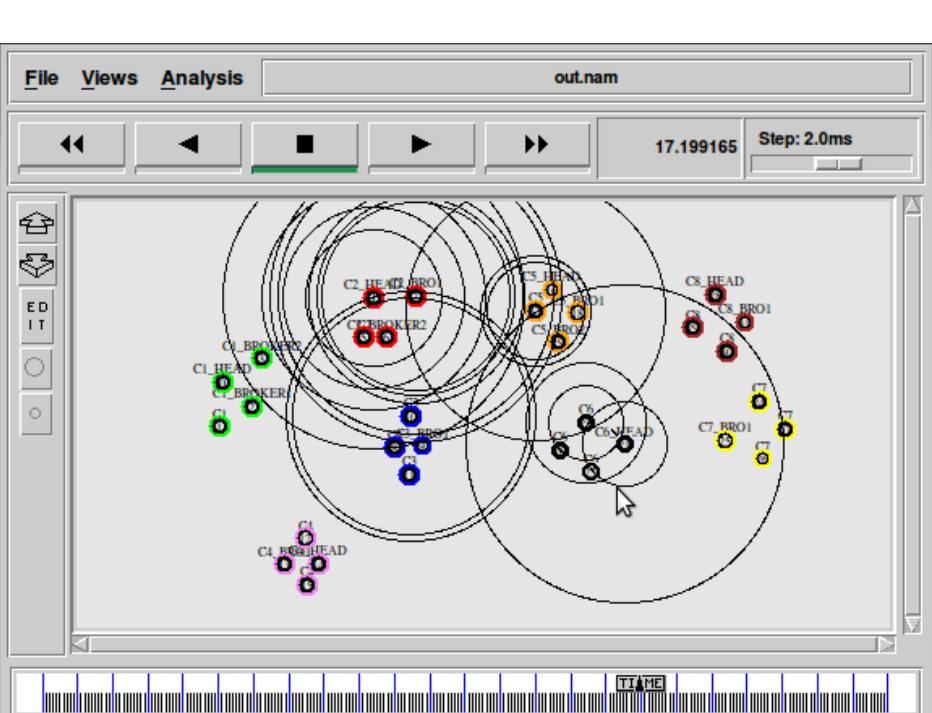
Figure 5. Dynamic broker and cluster formation.